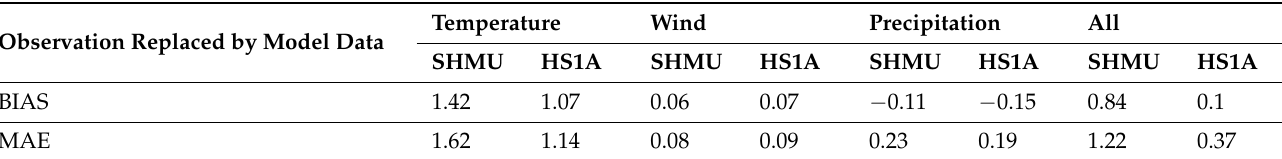
Table 10. As in Table 9 but for the 12–13 April 2021